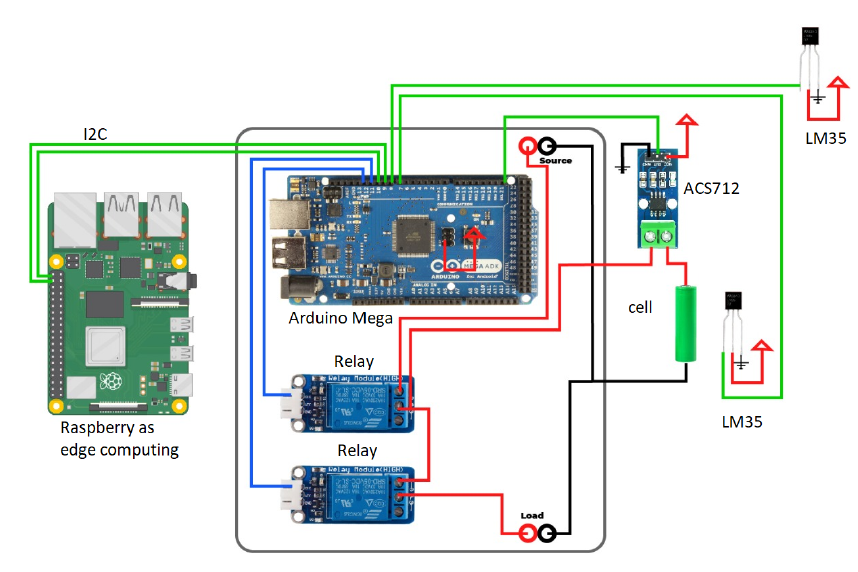
Figure 1. The schematic is used to monitor and control the cell. A Raspberry Pi4 is used to work as the edge computing, which communicates with an Arduino Mega. The Arduino Mega works as the BMS. The BMS collects the temperature sensors’ data and measures the cell’s voltage and current. Table 1. Table with the metrics from the confusion matrix.